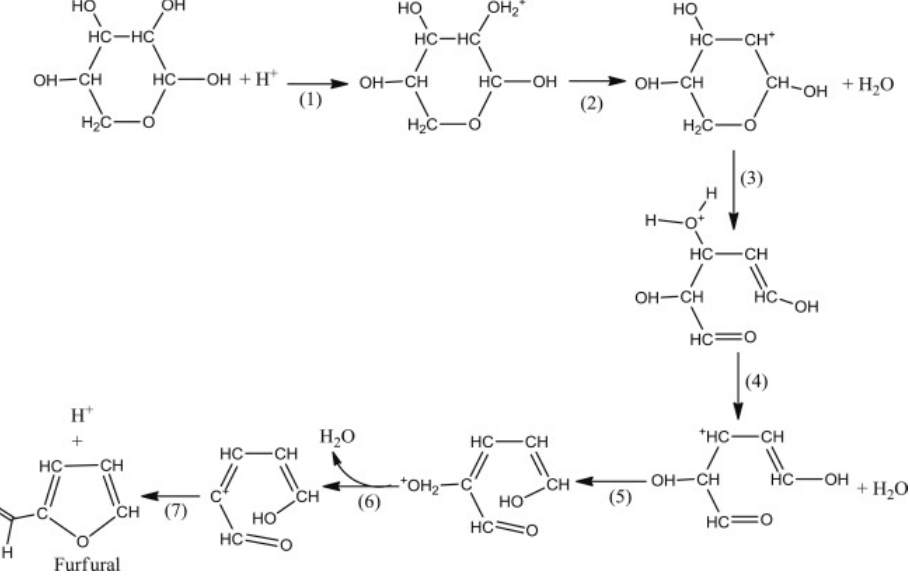
Figure 3. Acyclic dehydration mechanism from xylose to furfural [29]. Reproduced with permission from Ref. [29].